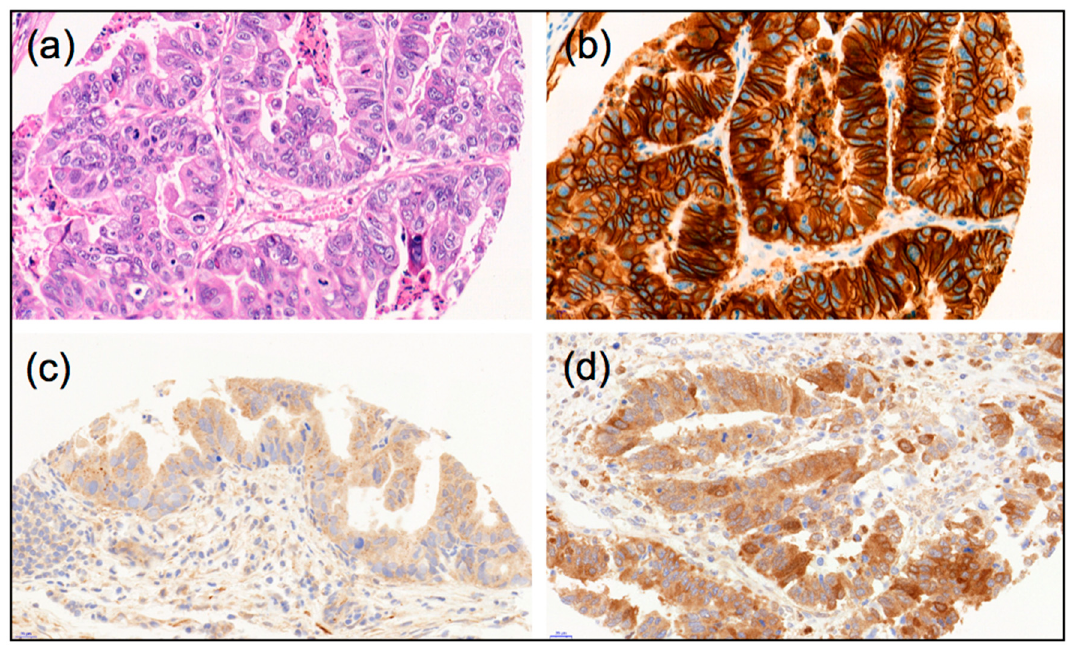
Figure 4. Examples of morphology, autophagy markers and Her2 immunohistological stainings of esophageal adenocarcinomas: ( a ) Hematoxylin-Eosin stain; ( b ) Example of strong Her2-positive staining; ( c ) Example of LC3B high dot-like staining; ( d ) Example of p62 high cytoplasmic/dot like staining, (40× magnification each).